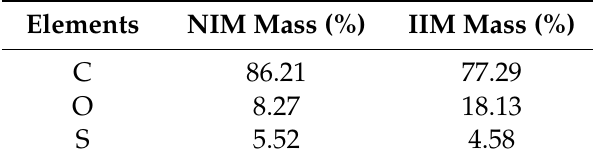
Table 1. EDX analysis results of the elements in NIM and IIM.